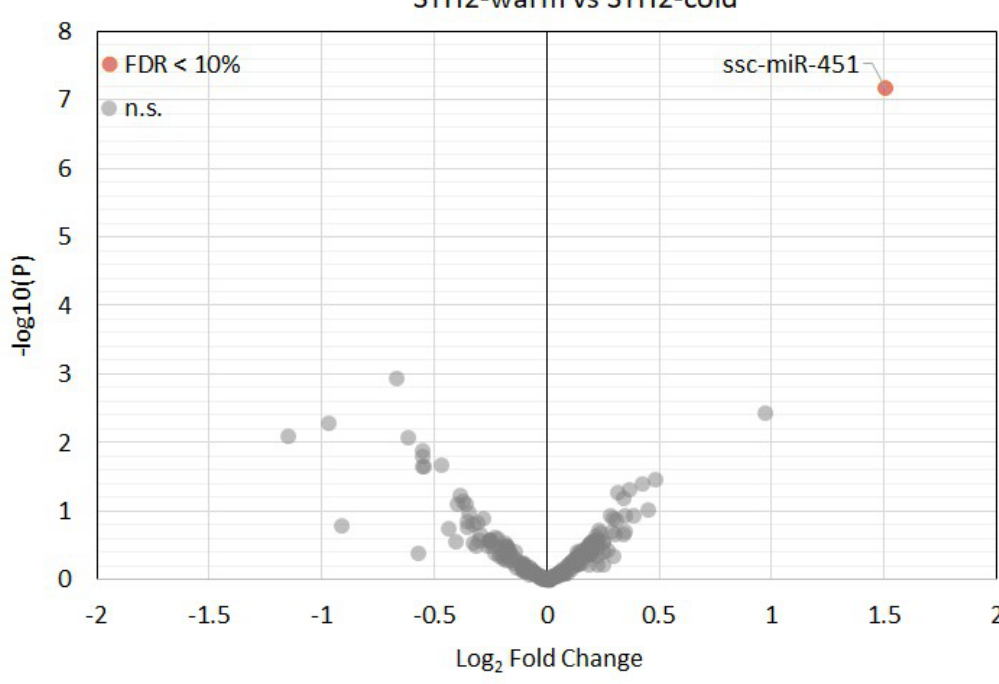
Figure 7. Volcano plot of the detected myocardial miRNAs in pigs with STH2-warm and STH2-cold cardioplegia arrest. Upregulated and downregulated miRNAs are in red. Statistically significant (adjusted p -value (FDR) < 0.1) miRNAs are depicted with their miRBase identifiers. FDR: false discovery rate.